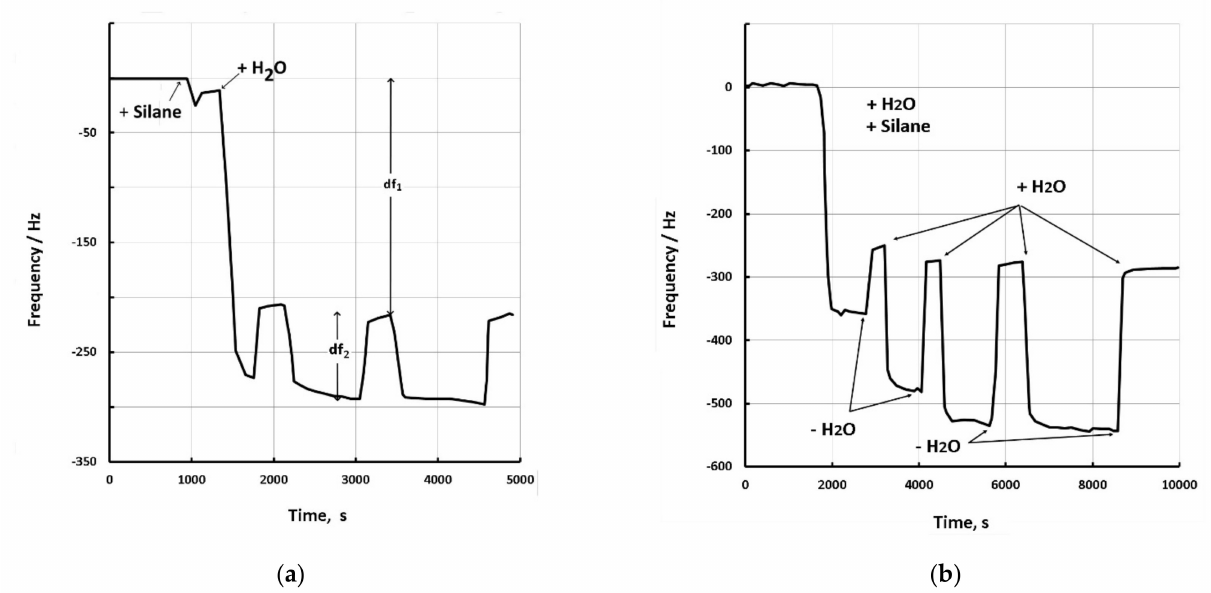
Figure 3. Monitoring of the frequency of iron QCM upon insertion of water and BTMS vapours. ( a )—the humidity of Ar flow is 71% RH and ( b )—98% RH [19]. Published with permission from SPRINGER NATURE